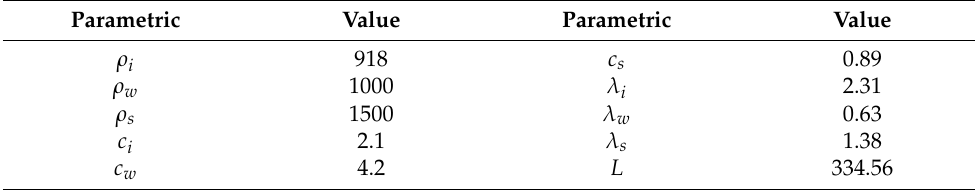
Table 2. Physical